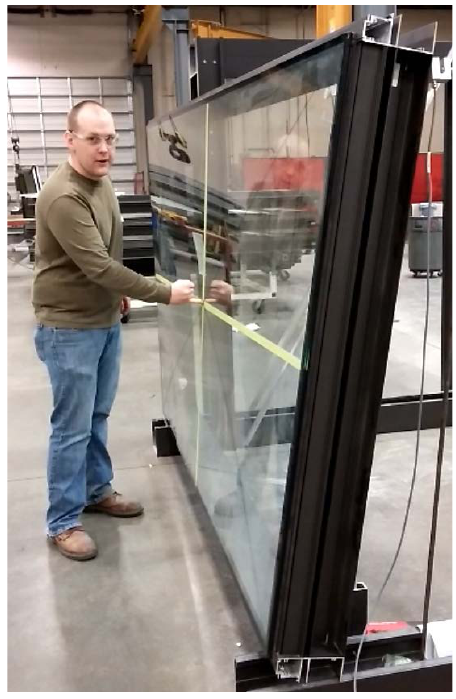
Fig. 9 Deformation of 9.02mm thick glass using the pinky finger